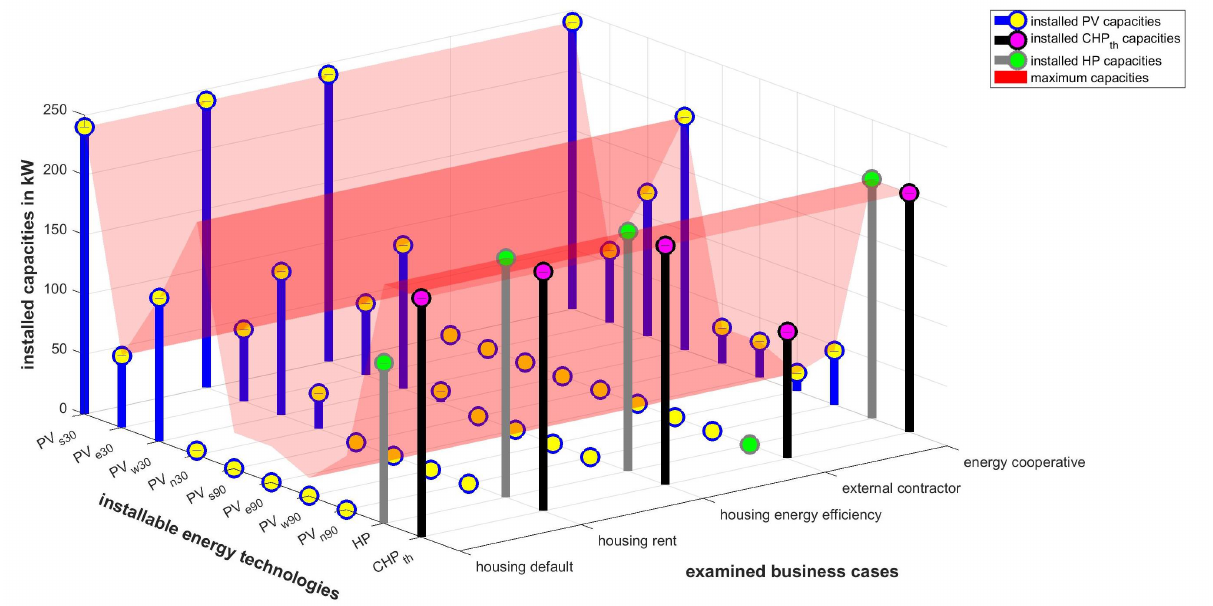
Figure 9. Comparison of installed and maximum capacities for the examined business